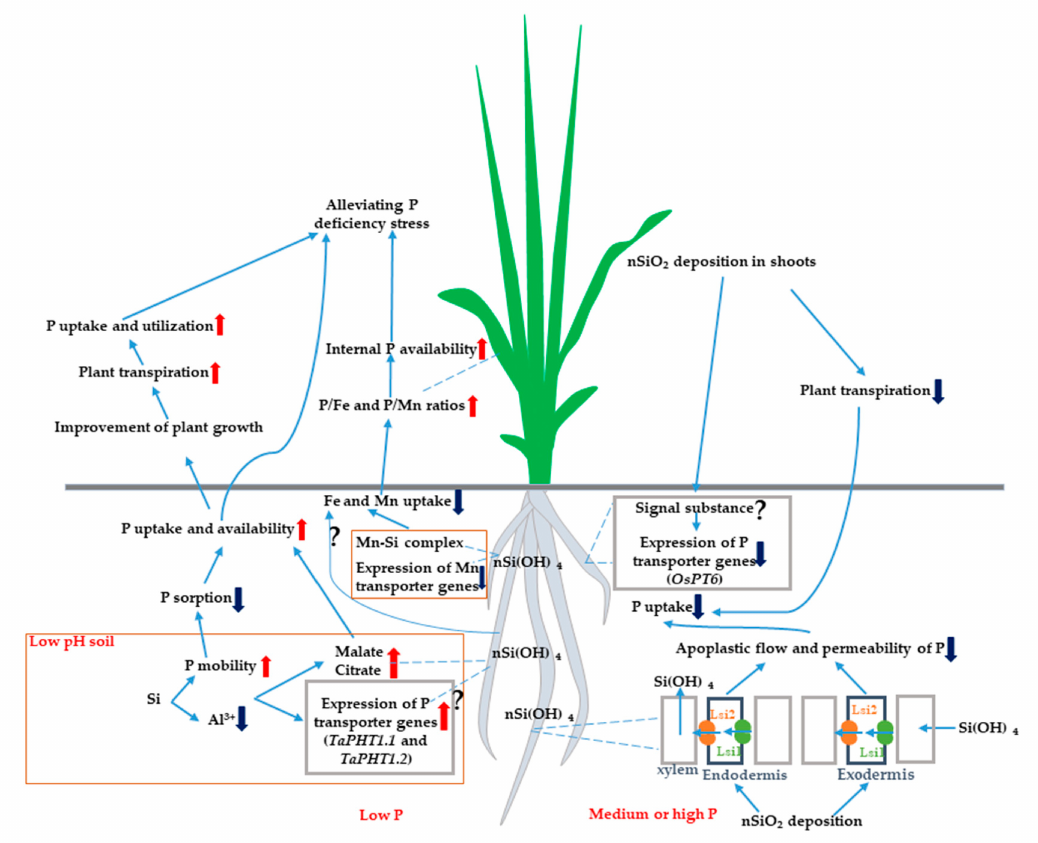
Figure 1. A schematic model for the beneficial impact of silicon on plant under P imbalance stress. The adaptive mechanisms of plant response to P-imbalance stress are complex. The regulatory effects of Si on P-deficiency or excess-P stress may constitute a complex sys- tem involving various biochemical and physiological processes as well. Consequently, systematic studies of Si-mediated alleviation of P-imbalance stress in plants with a fo- cus on molecular and genetic levels should provide a theoretical foundation for practical applications of Si to agricultural